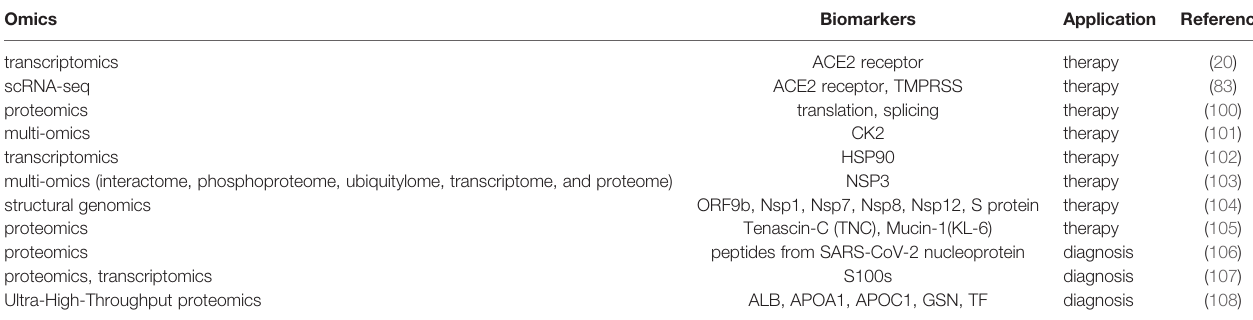
TABLE 2 | Summary of the main multiple omics data about biomarkers of COVID-19. Omics